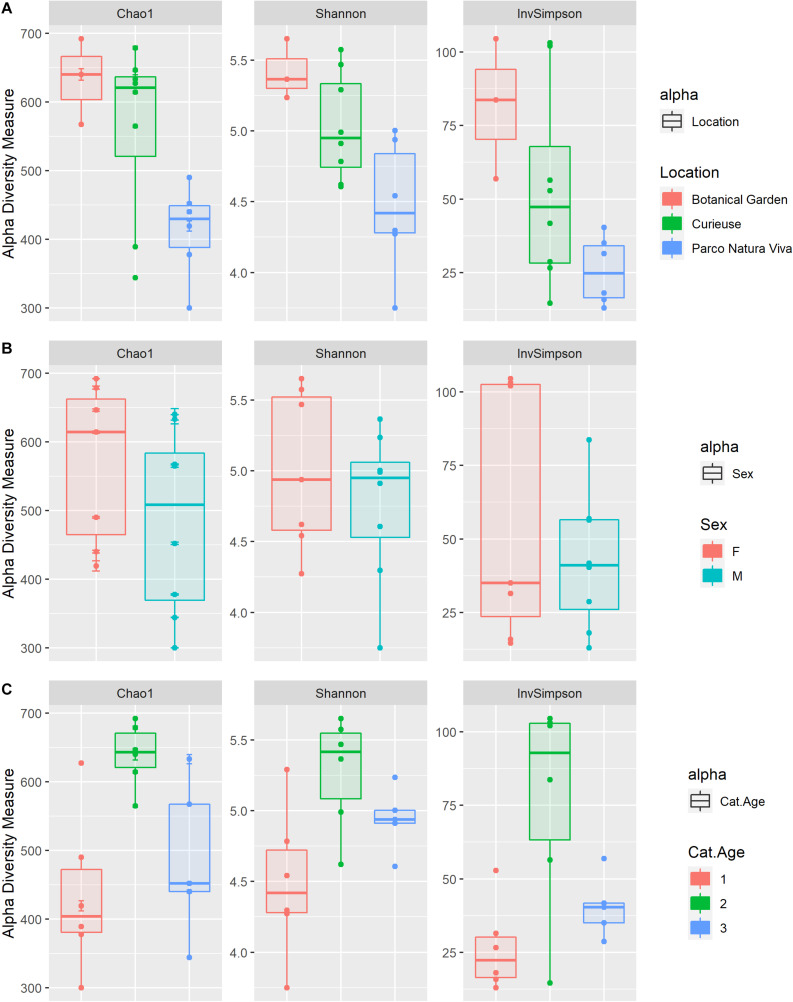
Box plots of the alpha diversity indices (Chao1, Shannon, InvSimpson) estimated for the different groups: Location (A), Sex (B), and Age categories (“1” < 20 years, 20 < “2” < 70 years, “3” > 70 years) (C).